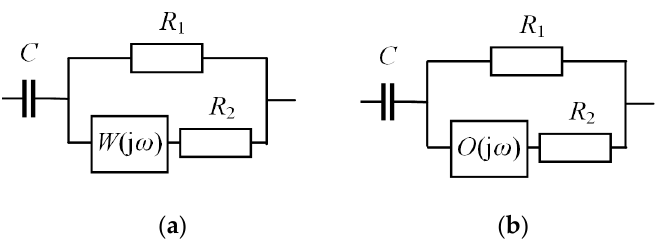
Figure 2. Topologies of fractional-order supercapacitor models: ( a ) four-parameter structure with Warburg impedance, ( b ) five-parameter structure with limited Warburg impedance.